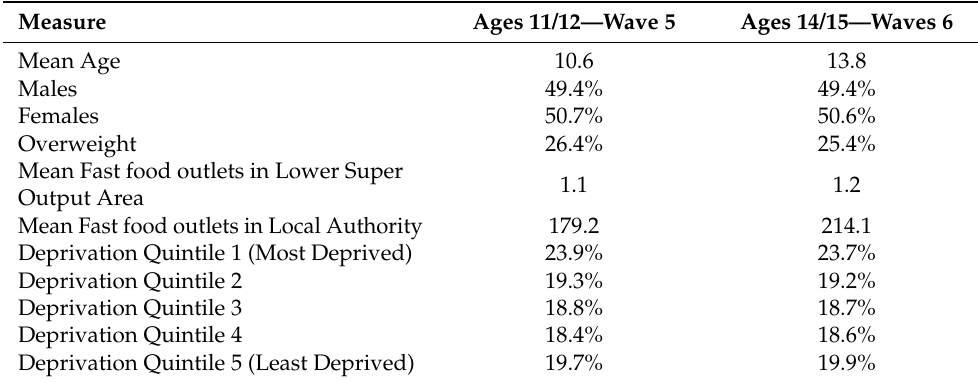
Table 1. Analytical sample characteristics by